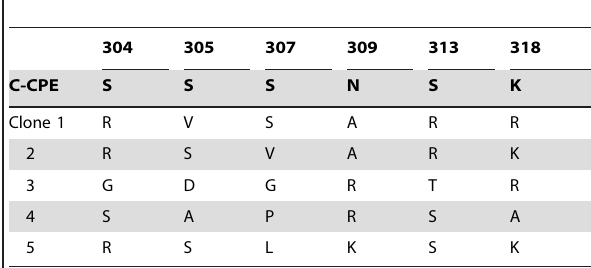
Table 2. CL4-binding phages.